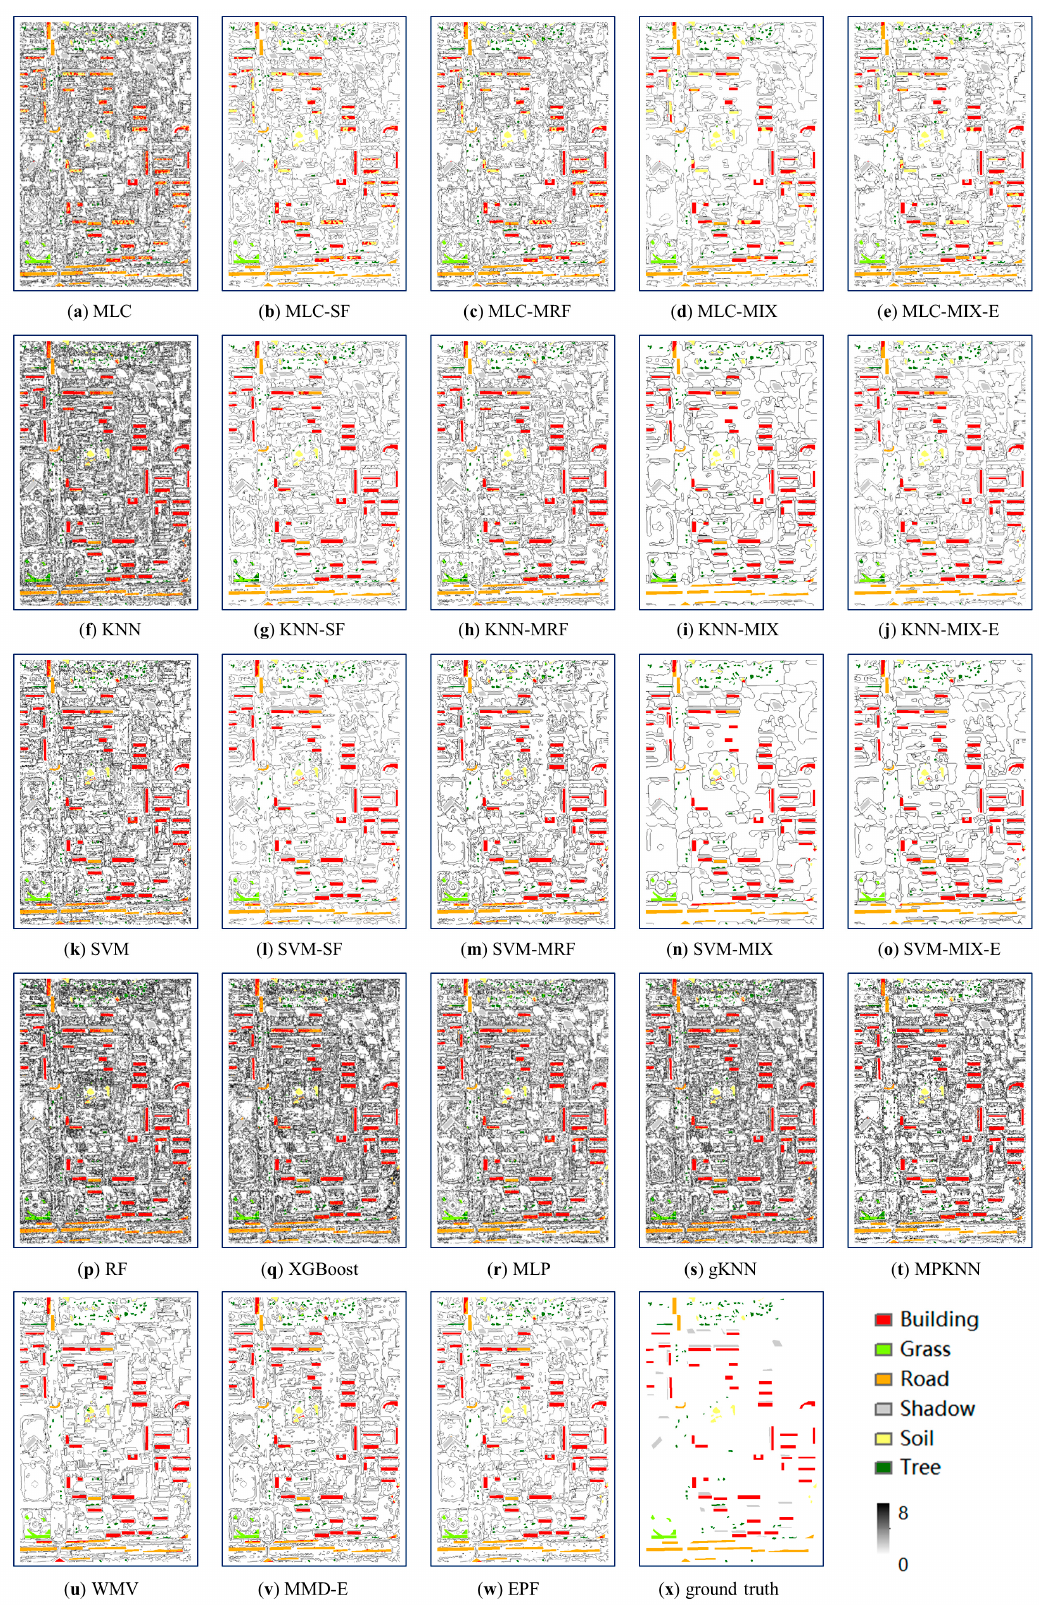
Figure 5. Classification results using different methods for the IKONOS image: ( a ) MLC, ( b ) MLC-SF, ( c ) MLC-MRF, ( d ) MLC-MIX, ( e ) MLC-MIX-E, ( f ) KNN, ( g ) KNN-SF, ( h ) KNN-MRF, ( i ) KNN-MIX, ( j ) MLC-MIX-E, ( k ) SVM, (l) SVM-SF, ( m ) SVM-MRF, ( n ) SVM-MIX, ( o ) SVM-MIX-E, ( p ) RF, ( q ) XGBoost, ( r ) MLP, ( s ) gKNN, ( t ) MPKNN, ( u ) WMV, ( v ) MMD-E, ( w ) EPF, and ( x ) ground-truth.